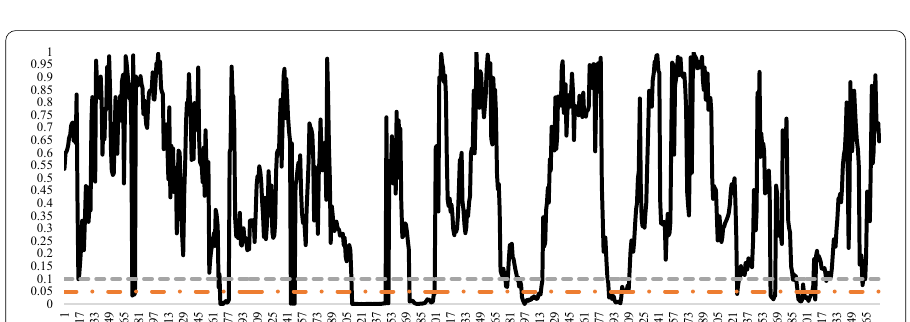
Fig. 17 The evolving p values of the AQ test statistic checked for the WTI in 50-day window